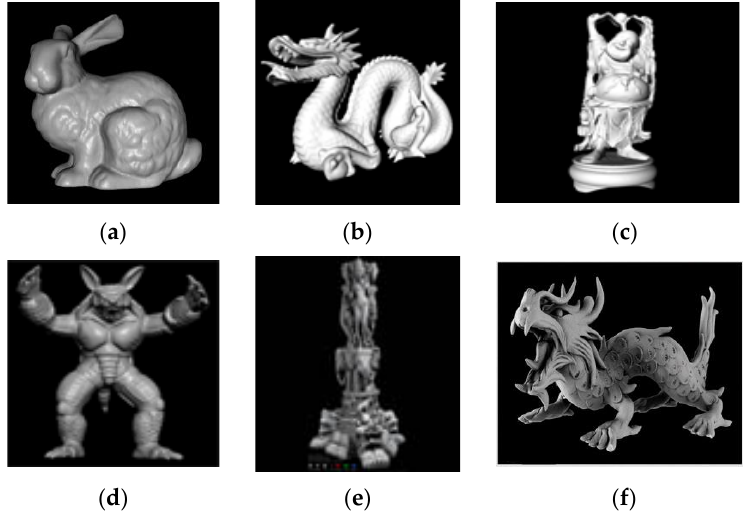
Figure 4. B3R dataset model, ( a ) Bunny. ( b ) Dragon. ( c ) Happy Buddha. ( d ) Armadillo. ( e ) statuette. ( f ) Asian Dragon.